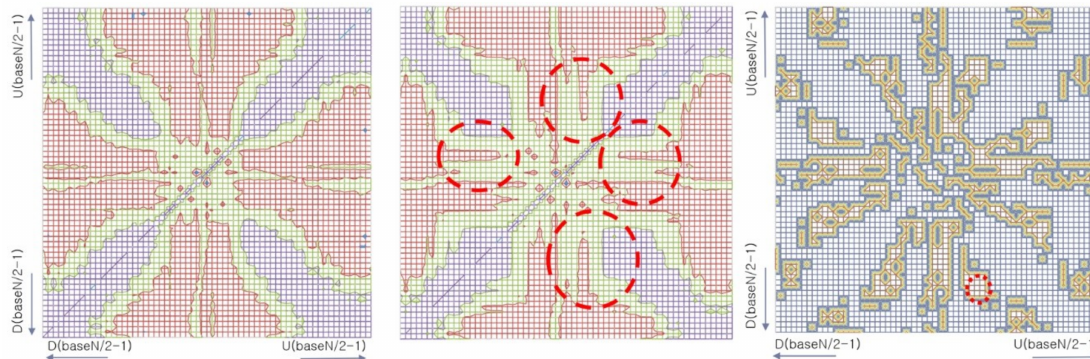
Figure 12. Visualized normal EEG model ( left ) and alcoholic EEG model ( center ). Different parts of the two models are marked by red circles ( center ). Effective parts for classifying the two models were accentuated by performing XOR the two models ( right